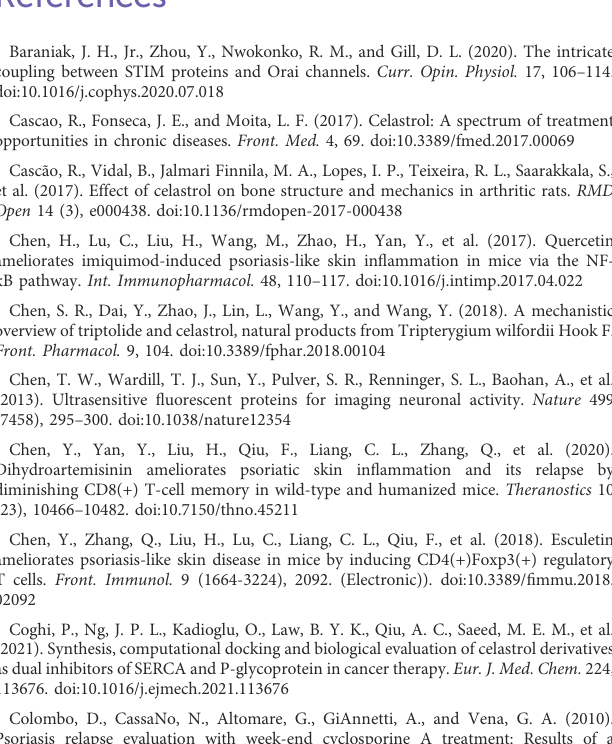
Effects celastrol on SOCE pathway in HEK cells. (A) 10 μ M celastrol decreased SOCE responses in STIM1-Orai1 co-expressing HEK STIM1-Orai1 cells as indicated by Fura-2 indicator. Left, typical traces; right, statistics. Before recordings, cells were bathed in Ca2 + imaging solution containing 1 μ M TG, 0 mM CaCl2, for 10 min. (B) Effects of 10 μ M celastrol on FRET signals between STIM1-YFP and Orai1-CFP in HEK STIM1-Orai1 cells. Left, typical traces; right, statistics. (C,D) 50 μ M celastrol increased the FRET signals between STIM11-237-CFP and STIM11-237-YFP to a level similar to those in store-depleted control cells. (C) Left, representative traces, right, statistics. (D) Statistics showing FRET signals at basal or store-depleted conditions. For all experiments performed in this fi gure, N = 3, ****, p < 0.0001, Student